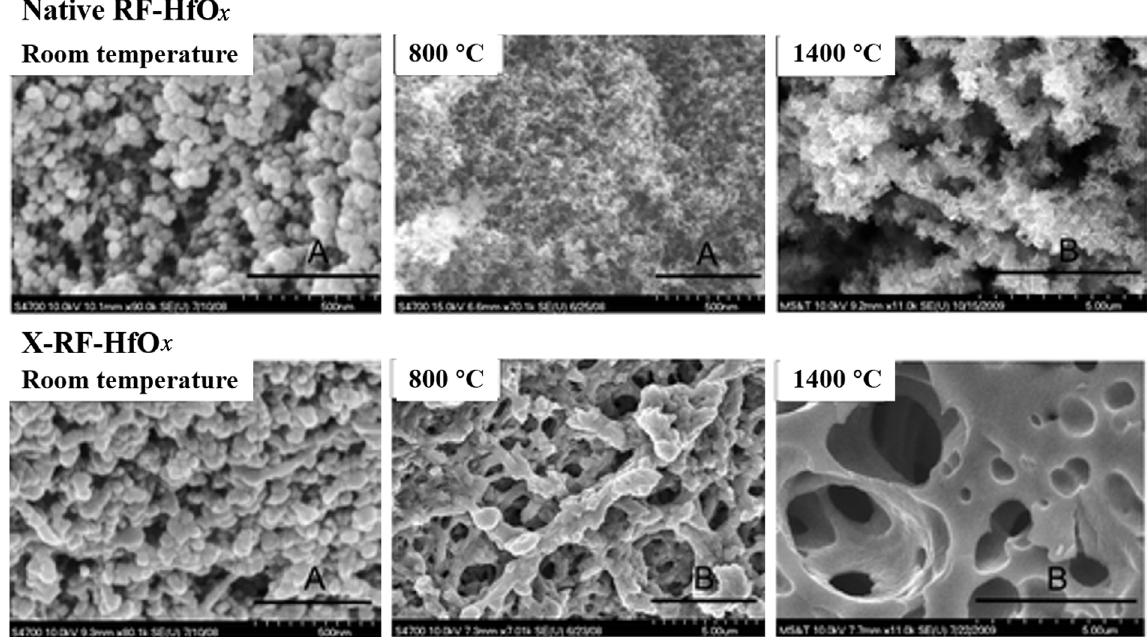
Fig. 9 Structural evolution by SEM upon pyrolysis (Ar, 3 h) of a representative RF-HfO x system convertible to HfC. Scale bars: A, 500 nm; B, 5 μm [26]. Reproduced with permission from Ref. [26], © Elsevier Ltd and Techna Group S.r.l.